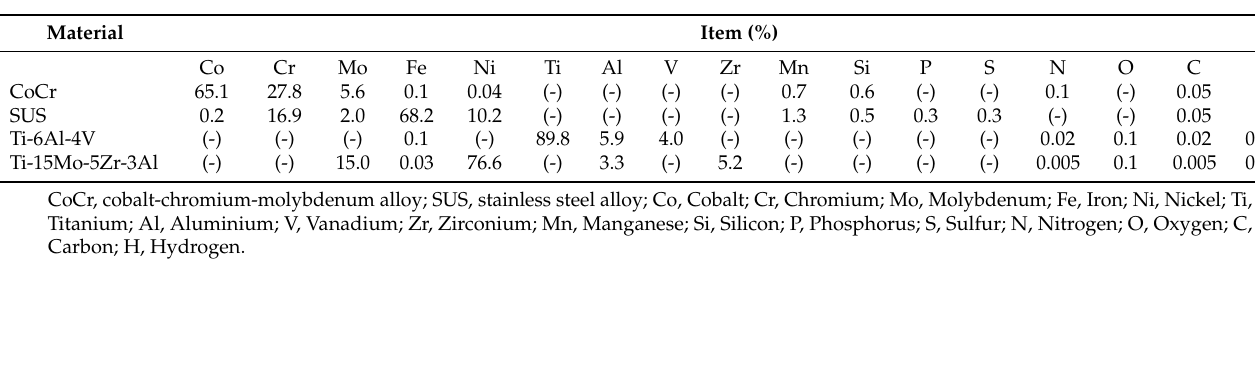
Table 1. Chemical composition of each metal